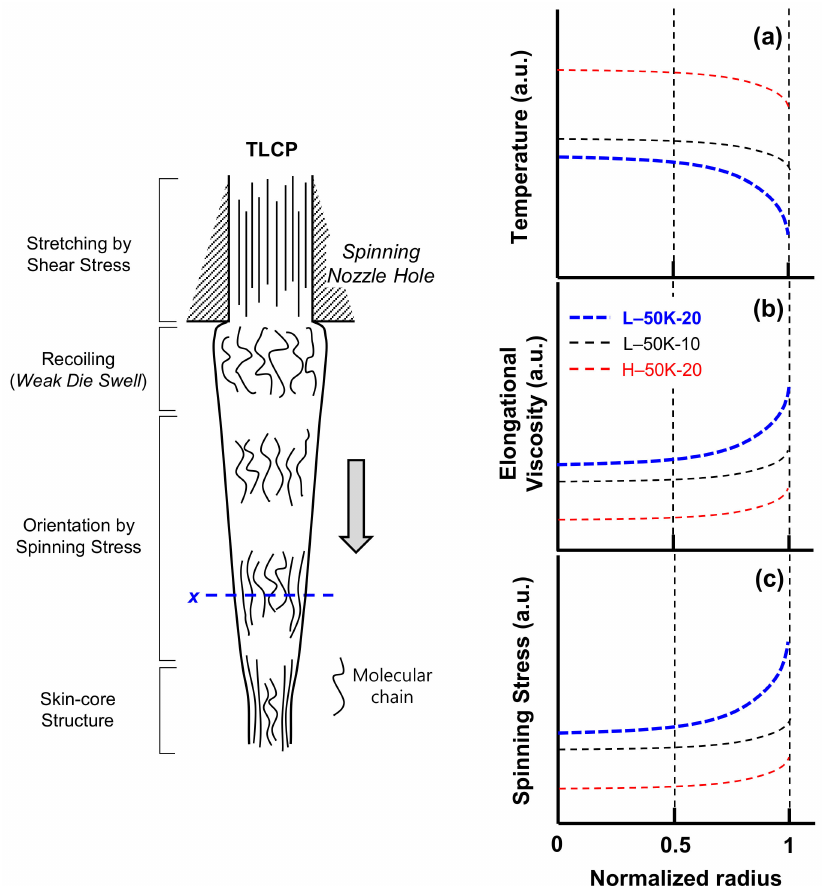
Figure 10. Schematic representation of the structural development of the TLCP fibers in high-speed melt spinning, and the variation of profiles of temperature, elongational viscosity and spinning stress in the cross-section of TLCP fibers (L-50K-20) at the distance of approximately 15 cm from the nozzle in the spinline by the change of the spinning temperature (H-50K-20) and draft